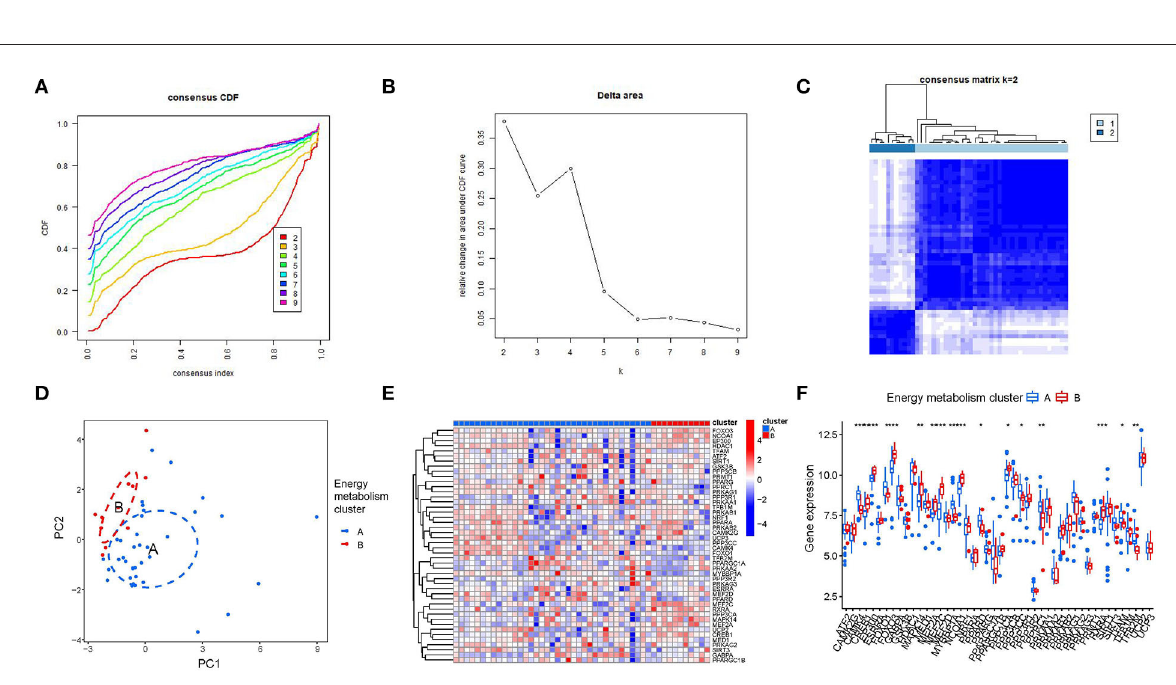
FIGURE2 Consensus clustering analysis of energy metabolism-related genes. (A) The cumulative distribution function (CDF) curve of samples in the HF cohort. (B) The relative change in area under the CDF curve for k = 2–9. (C) Sample clustering heatmap when consumption k = 2. (D) PCA analysis for cluster A and cluster B. (E,F) The different expression of 48 genes between two